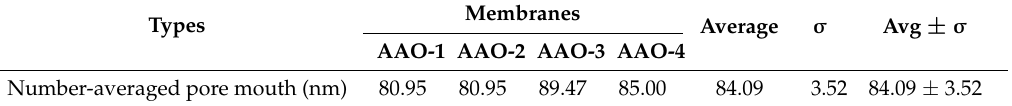
Figure 7. ( a ) Averaged pore mouth size distribution for Anopore TM membranes derived from four replicate samples; ( b ) liquid flux and pressure relationship of AAO-1 membrane. Table 4. Summary of MLLDP results for four replicate samples of nominal 100 nm Anopore TM membrane.